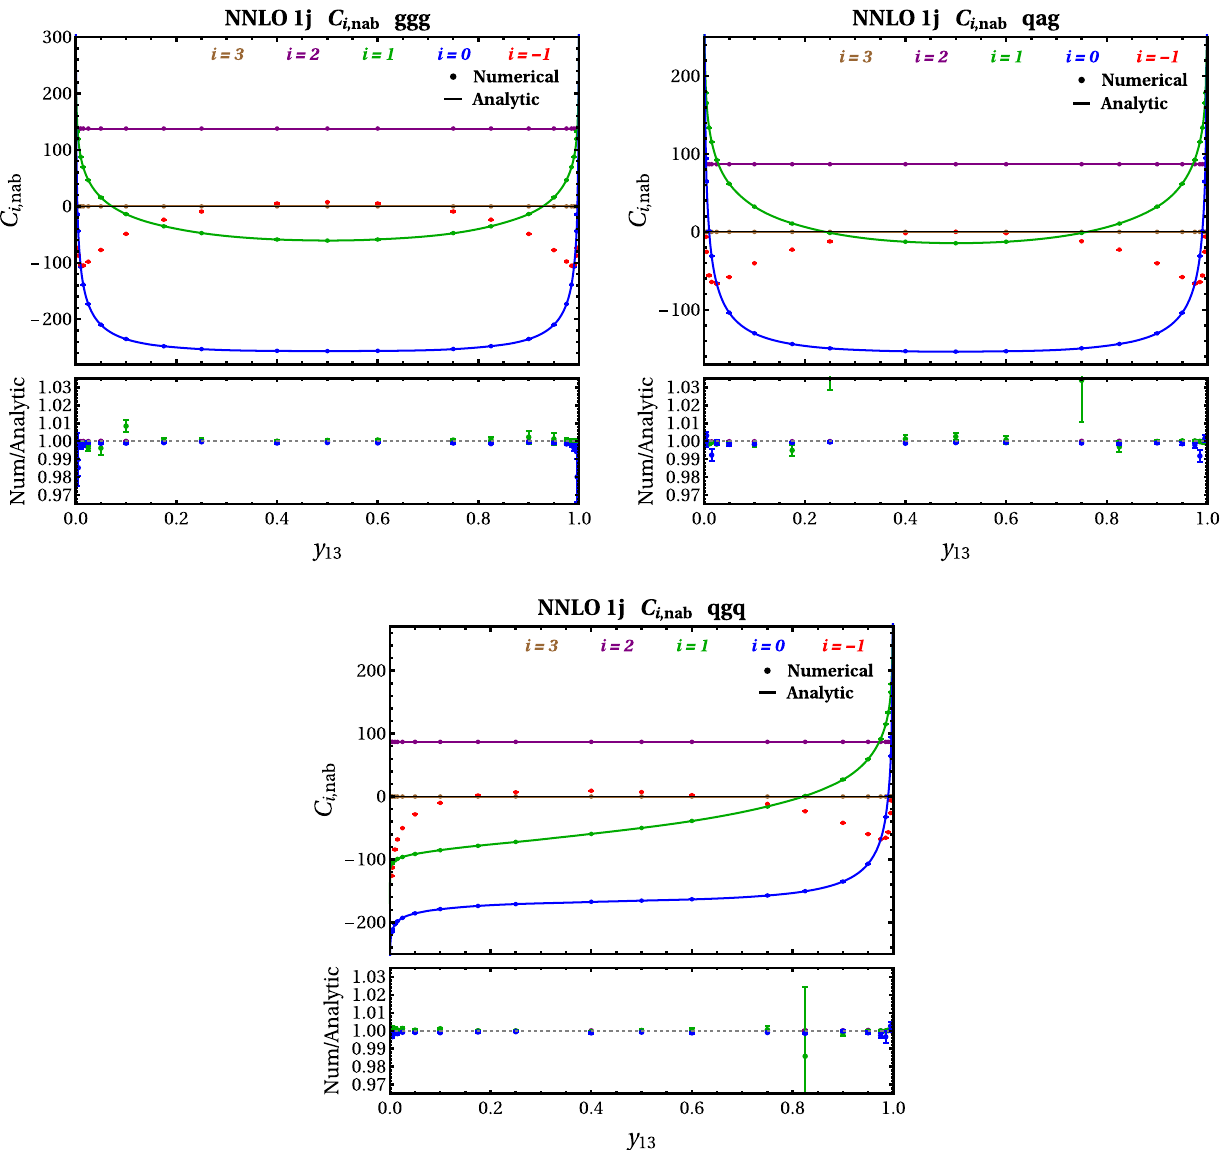
Fig. 4 Numericalresultsforthenon-Abelianpartofthe1-jettinesssoftfunctionatNNLOforthepartonicchannels gg → g , q ¯ q → g ,and qg → q . We plot the coefficients of δ( T 1 ) and L n ( T 1 ) with n = 0 , 3 as functions of y 13 ∈ [ 0 , 1 ] . The analytic results are taken from Refs.